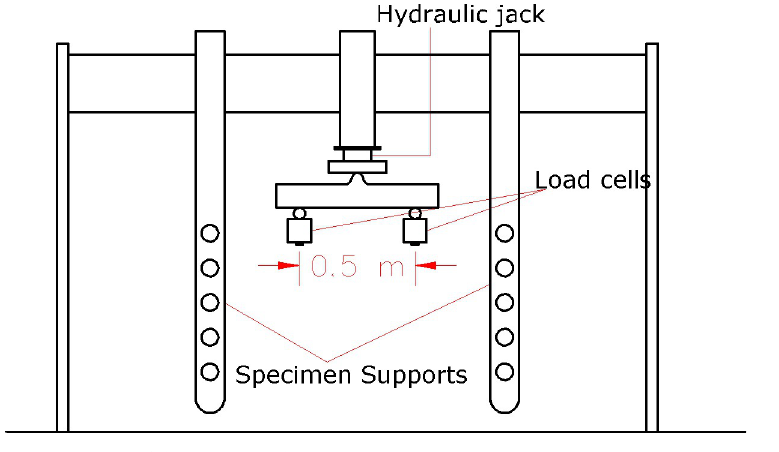
Fig 5. Diagram of the testing machine.